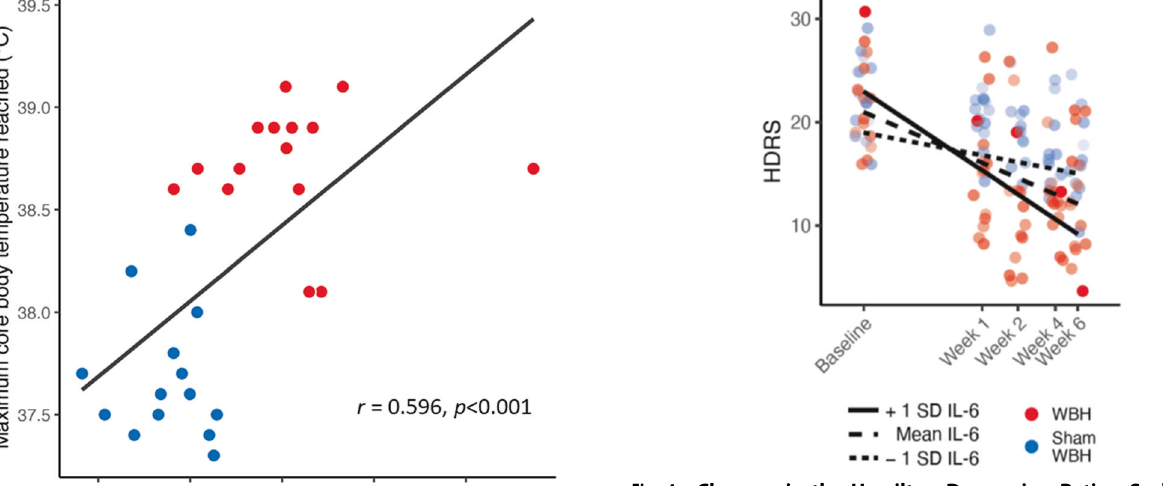
Fig. 4 Changes in the Hamilton Depression Rating Scale (HDRS) over time as moderated by varying concentration levels of interleukin (IL)-6 assessed immediately post-whole-body hyperthermia (WBH). Time along the x -axis is labeled accurately but displayed on a natural log scale to re fl ect how the data were analyzed. Data points have been offset slightly ( “ jittered ” ) from their original positions to reveal overlapping data points. Red points indicate data measured from participants randomized to the WBH condition, and blue points indicate data measured from participants randomized to the sham WBH condition. Point opacity is based on IL-6 concentrations, with highest concentrations being the most opaque. The solid line represents the relationship between HDRS and time when cytokine concentrations are one standard deviation (SD) above the mean, the long-dashed line represents the same relationship when cytokine concentrations are at their mean value, and the short-dashed line represents that relationship when cytokine concentrations are 1 SD below the mean.